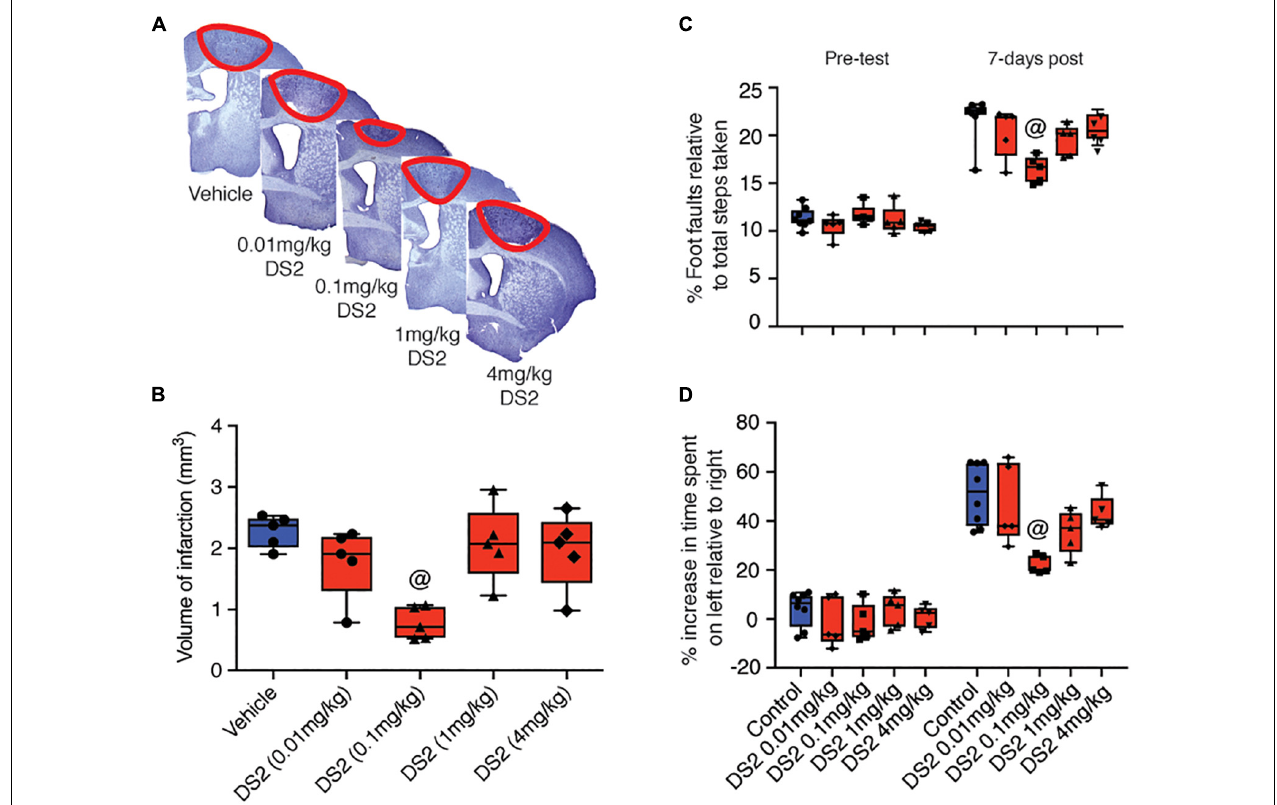
FIGURE 1 | Treatment with DS2 reduces infarct volume and improves functional outcomes post-stroke. Mice were subjected to focal stroke and injected intraperitoneally with either DS2 (0.01, 0.1, 1 or 4 mg/kg) or vehicle 1 and 24 h after the surgery. The brains were collected 7 days later, stained with cresyl violet and the stroke volume was calculated. (A) Representative cresyl violet-stained sections of animals treated with vehicle or three different concentrations of DS2. (B) Mice injected with 0.1 mg/kg DS2 had significantly smaller strokes than untreated animals. Baseline motor function was established by grid-walking and cylinder test 1 week prior stroke surgery. Mice treated with either vehicle or DS2 (0.01 0.1, 1, and 4 mg/kg) at 1 and 24 h post-stroke induction were assessed in the (C) grid-walking (foot-faults) and (D) cylinder task (forelimb asymmetry). Data are expressed as mean ± SD for n = 5-7 per group. @ P < 0.01 compared with vehicle